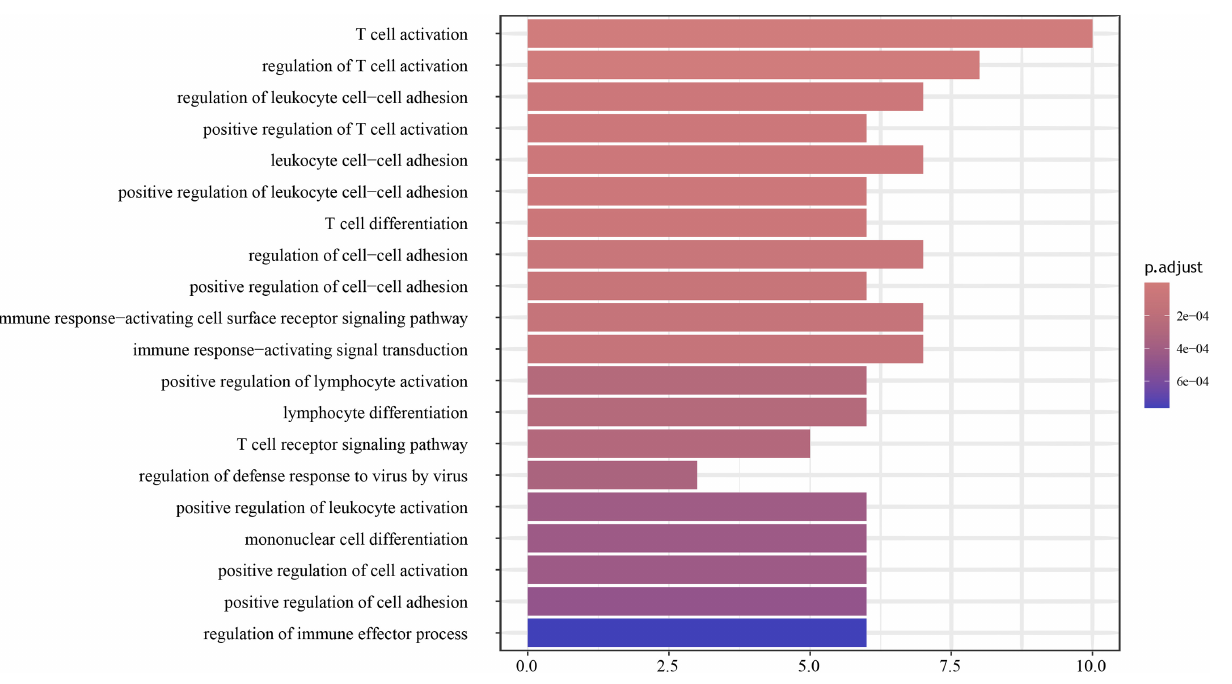
FIGURE 4 | Enrichment analysis results of biological process (BP) was constructed by R package. The biological functions chiefly enriched in tumor immune